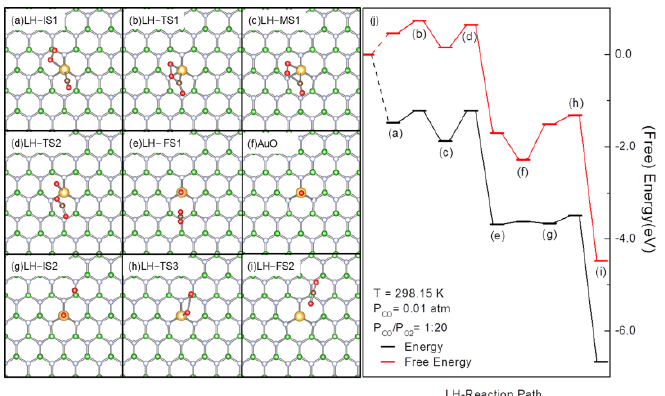
Figure 2. Optimized structures of the reaction species involved, including reaction intermediates, transition states and products ( a ) – ( i ), and (free) energy profiles ( j ) for CO oxidation over AuBN through the rLH pathway. In ( a ) – ( i ), the B, N, C and Au atoms are in green, light blue, brown and gold, respectively. In ( j ), the bracketed letters correspond to the structures shown in ( a ) – ( i ).